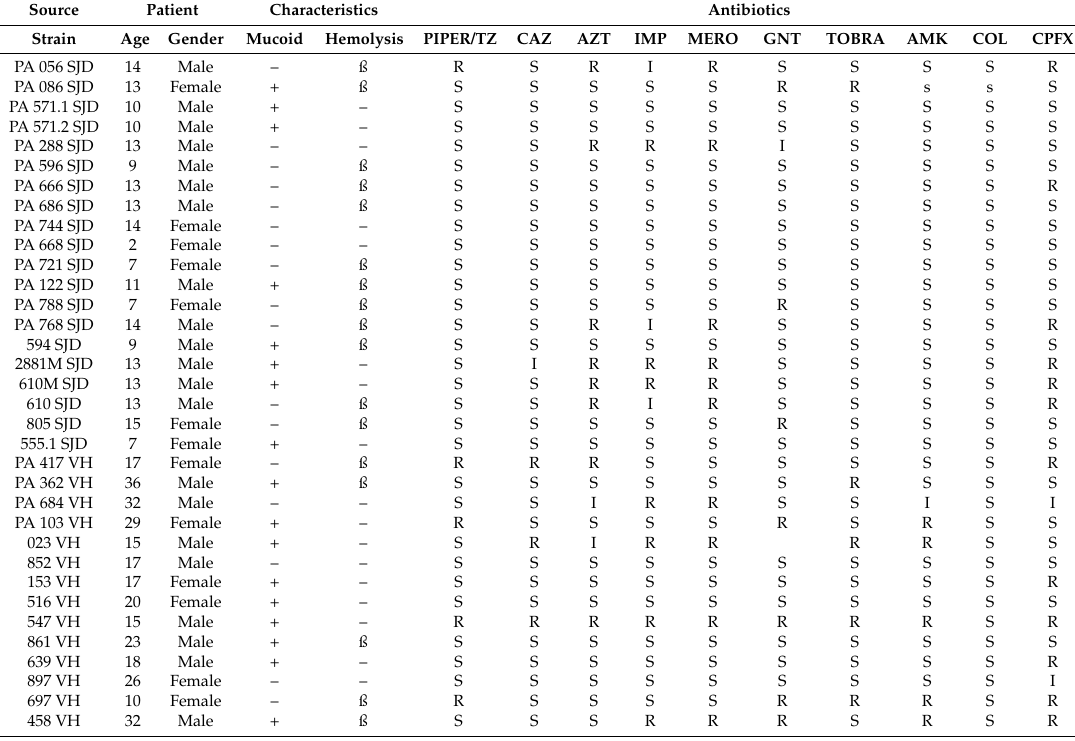
Bacterial strains used in this